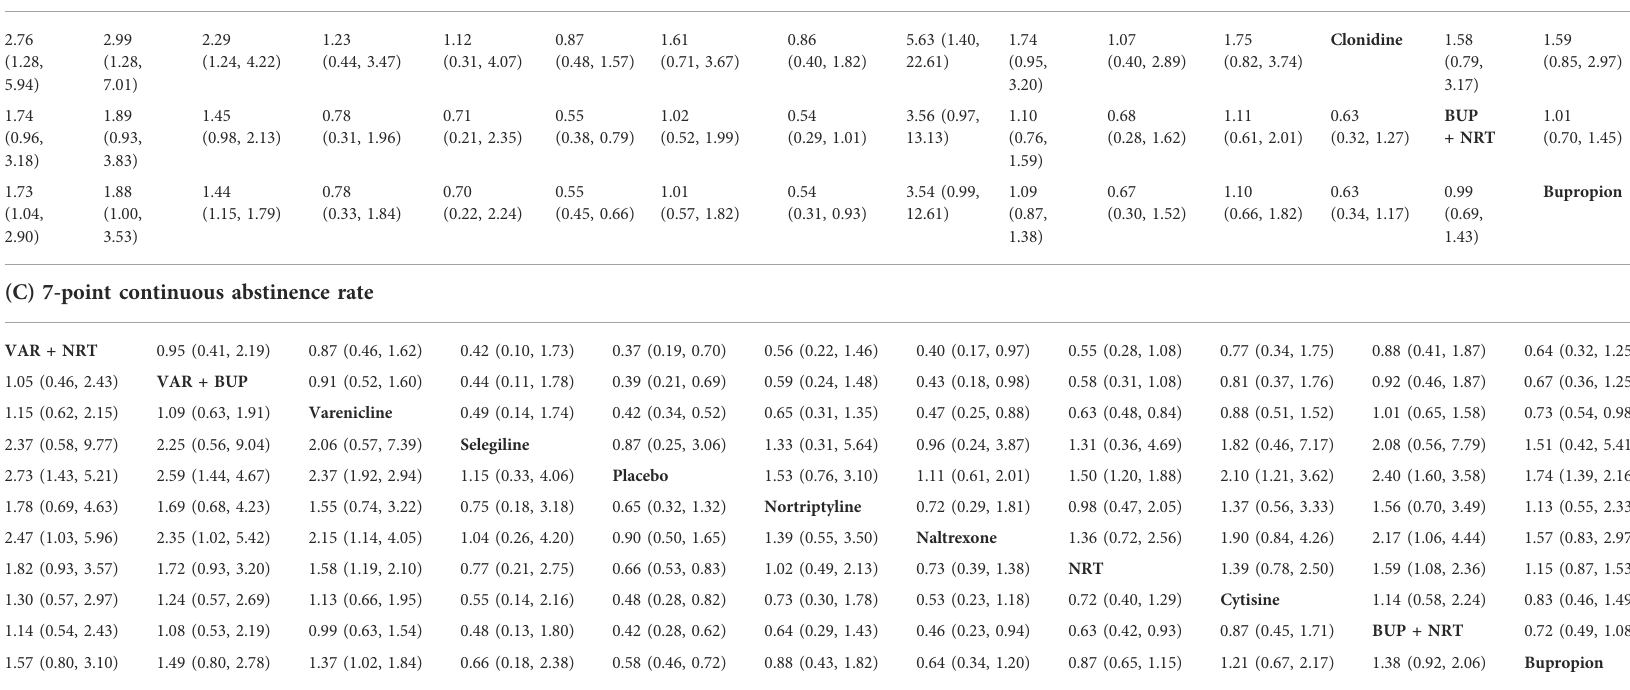
TABLE 2 ( Continued ) The results of network meta-analysis for all pairwise